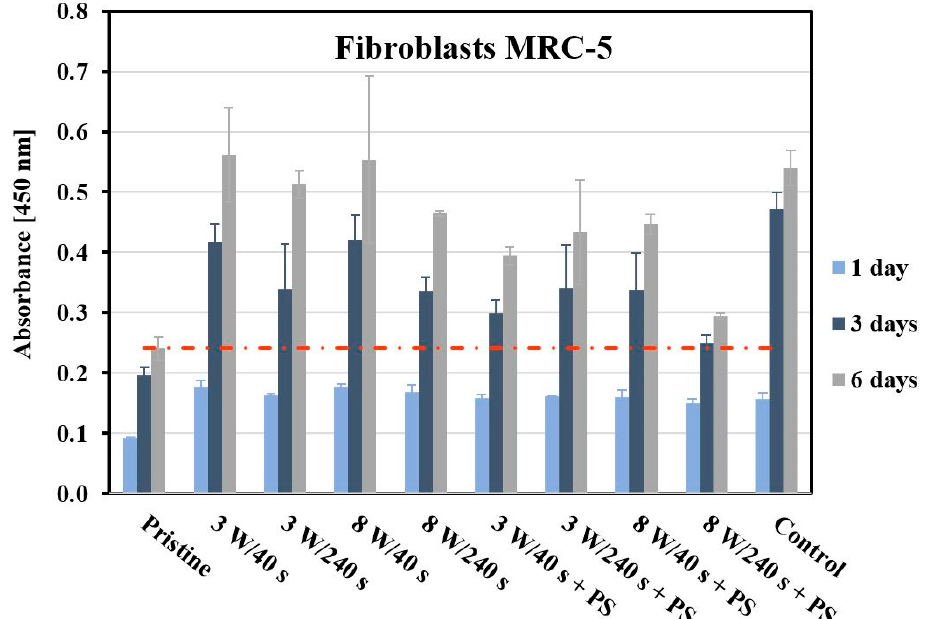
Figure 12. Metabolic activity of primary human fibroblasts (MRC-5) growing on the studied FEP substrates. Cell metabolic activity was determined spectrophotometrically using WST-1 assay at 450 nm at 1, 3, and 6 days post-seeding. As a control, glass coverslips were used. The error bars represent the standard error of the mean of three replicates.